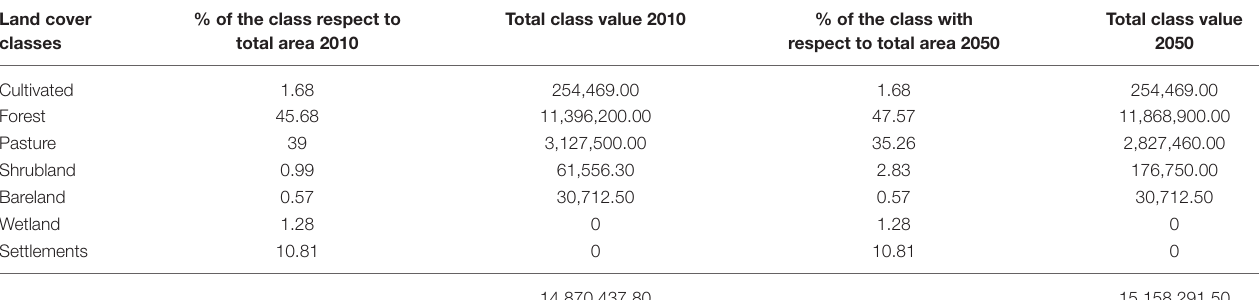
TABLE 5 | Variations in the total land values due to land cover changes in the B ˘ al ˘ aneasa study